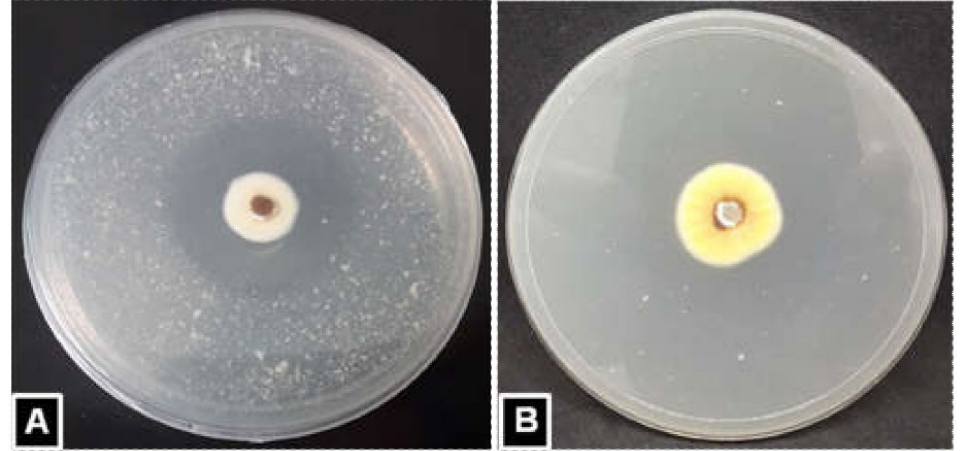
Figure 1. Proteolytic activity of representative fungi isolate (representative of 10 isolates) on the skimmed milk agar (SMA) medium, showing clear zone around the colonies incubated for 48 h at 28 °C. ( A ) Isolate PLTP5; ( B ) Negative control (Isolate: TS13).